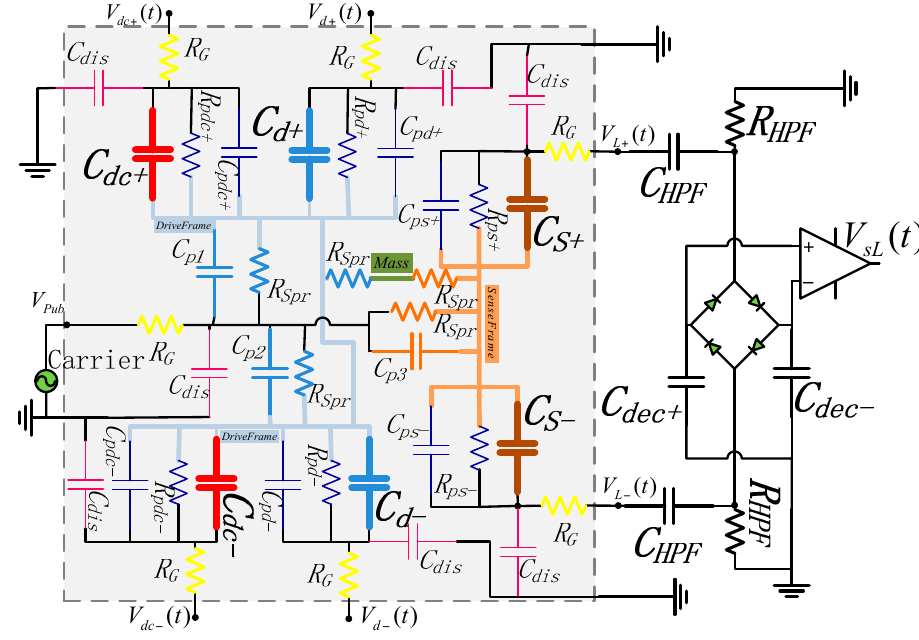
Figure 3. Electric model and interface of each single mass.